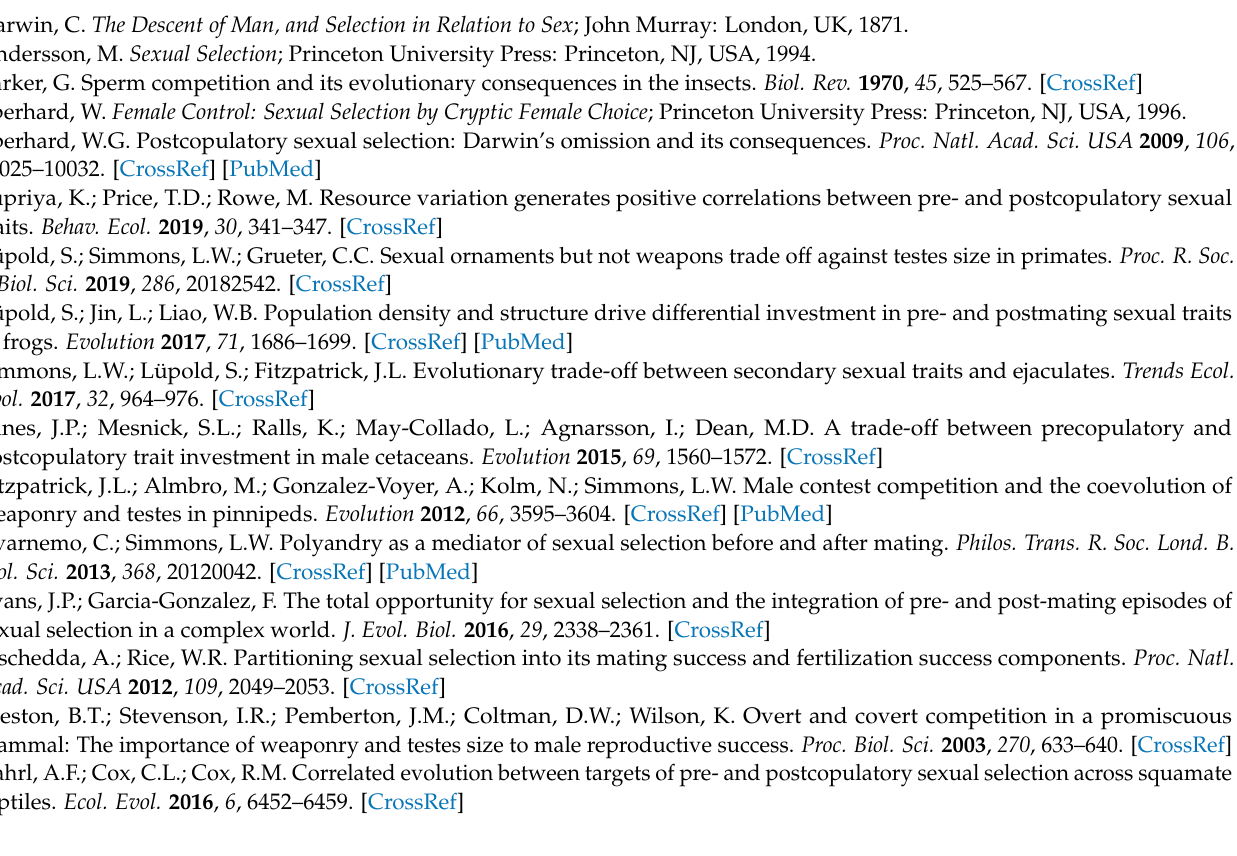
vs. sperm trait correlation. Figure S2. Strength of selection on the male trait when both episodes of selection were active or only pre-copulatory episode was active. Figure S3. Opportunity for selection and its components, as a function of the male trait vs. sperm trait correlation and which episodes of selection were active. Table S1: Partitioning total variance in reproductive success, T , into copulation success, C , average fecundity of the female mates, N , and fertilization success, F . Table S2: Complete model results for the number of spurious significant test results in the negative direction, for the main models and for additional simulation conditions presented only in the supplement. Table S3: Full model results for estimated effects of different analytical approaches, for the main results presented in the text and for additional simulation conditions. Table S4. Estimated effect size (Cohen’s d ) for bias in parameter estimates due to correlated traits for additional simulation conditions described in the supplement. Table S5. Model results for how components of opportunity for selection change depending on which episodes of selection were active, the male trait vs. sperm trait correlation, and their